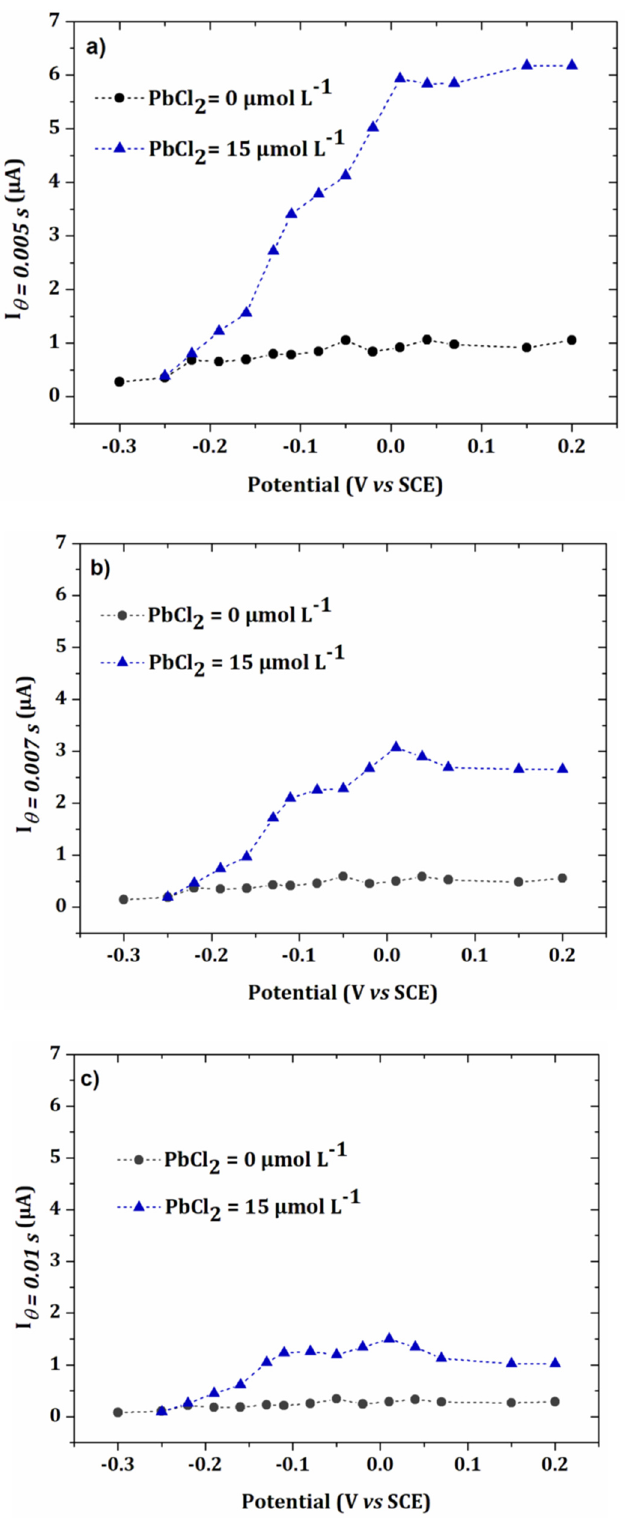
Figure 7. I-E curves obtained from chronoamperomety of Figure 6 for θ equal to ( a ) 0.005 s, ( b ) 0.007 s and ( c ) 0.01 s.